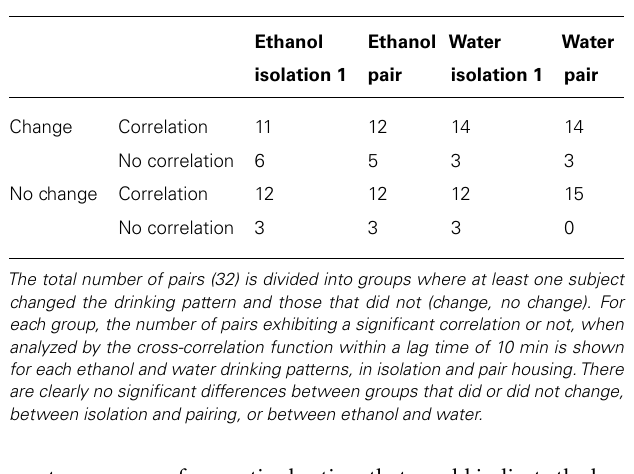
Table 1 | Number of pairs exhibiting significant correlations in drinking patterns.